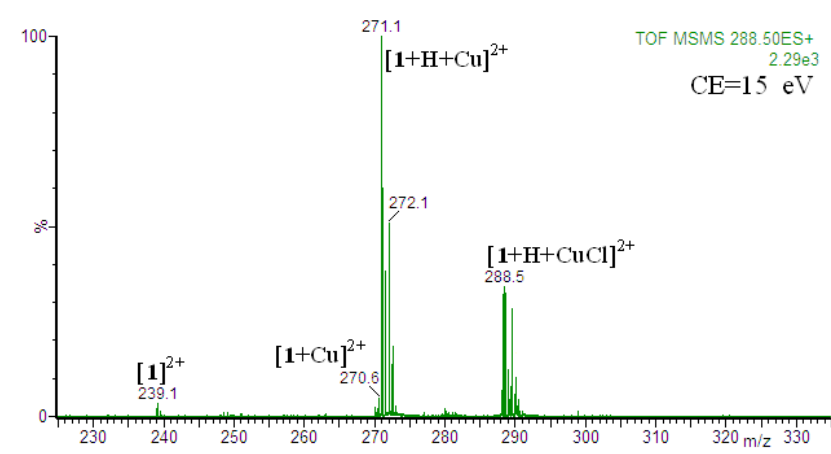
Figure 4: CID-MS/MS spectrum of [ 1 +H+CuCl] 2+ ion in the m/z range of interest. [ 1 +Cu] 2+ ion formed by the loss of HCl molecule is